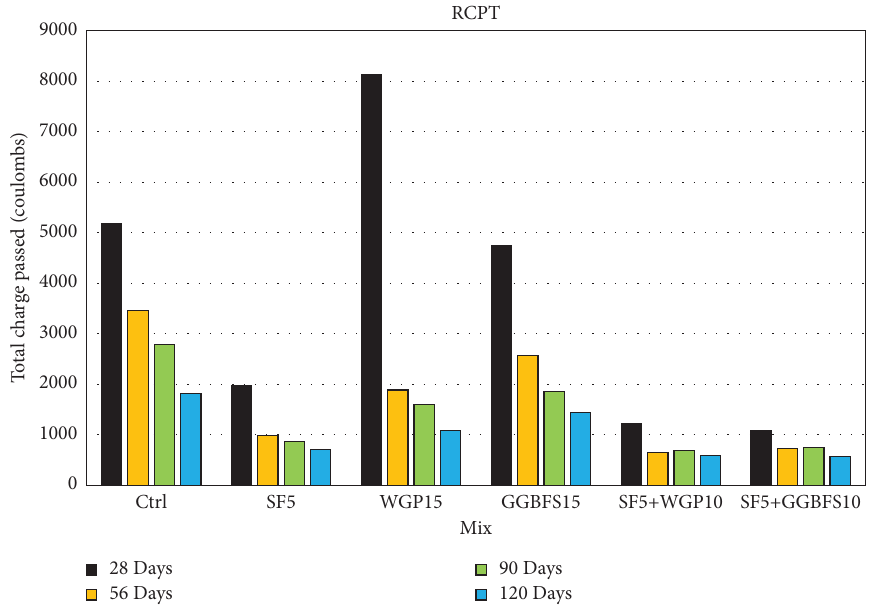
Figure 11: Rapid chloride penetrability test (RCPT) results of concrete mixtures. Table 4: Chloride ion penetrability based on ASTM C1202. Chloride ion